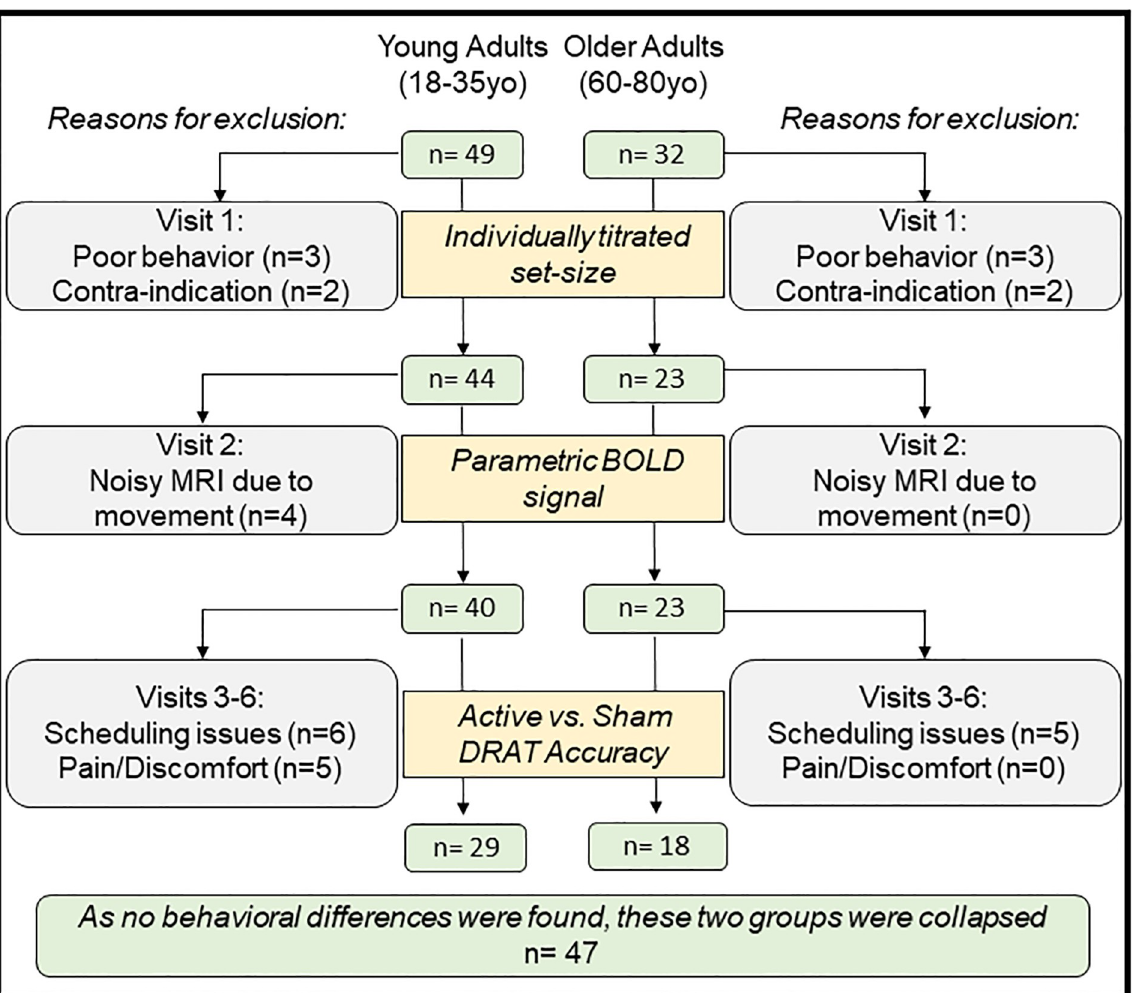
Fig 1. Consort diagram showing the recruitment, exclusion and inclusion numbers.